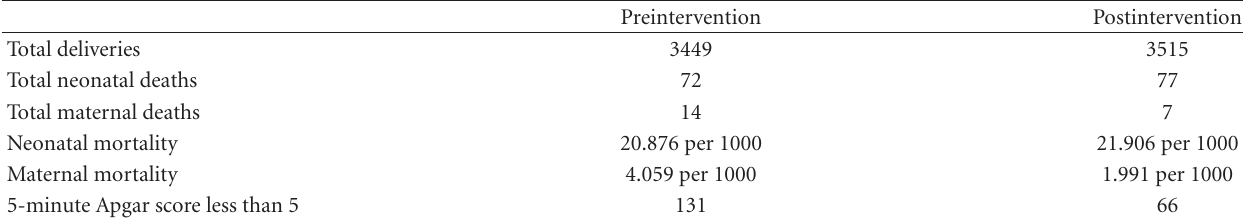
Table 3: Birth outcomes at St. Gabriel’s Hospital before and after LPCH neonatal resuscitation